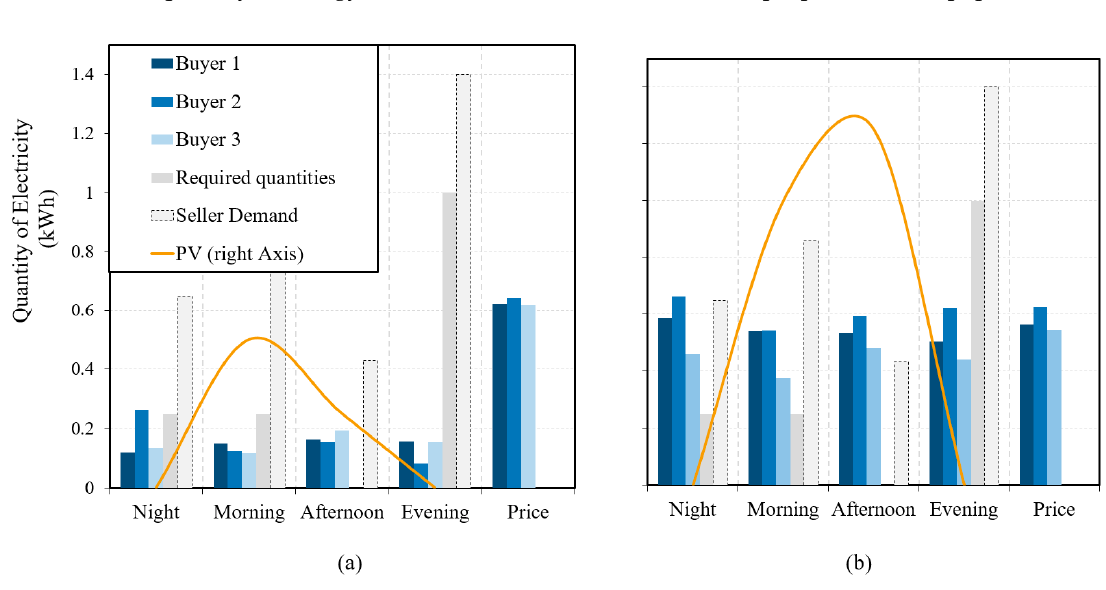
Figure 1. Outcomes of negotiations for the three different types of buyer agents implementing expert strategy against the seller, also implementing expert strategy; for the case of a cloudy day ( a ) and of a sunny day ( b ).